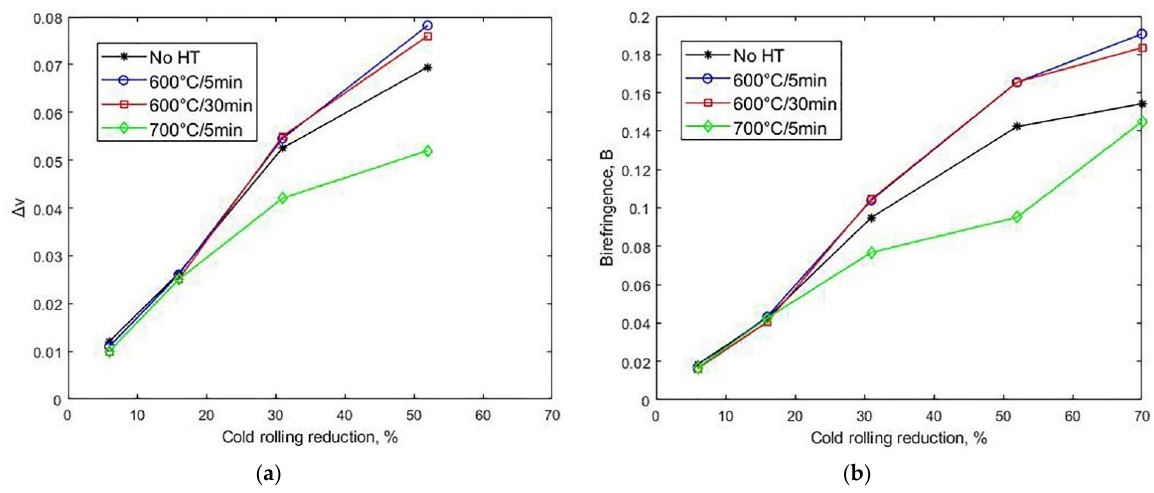
Figure 9. Effect of recrystallization annealing after cold rolling on ( a ) difference in Poisson’s ratio ( ∆ ν = ν 32 − ν 31 ) and ( b ) acoustic birefringence ( 𝐵 ). As reference, data for specimens without heat treatment (No HT) are also shown. From the preceding discussions, while hardness values after annealing the previ- ously cold-rolled TWIP steel may show that there is partial or total recrystallization, the elastic constants and especially Δ𝜈 and birefringence clearly evidence the effect of the re- crystallization process on anisotropy. Thus, although these elastic parameters bear no